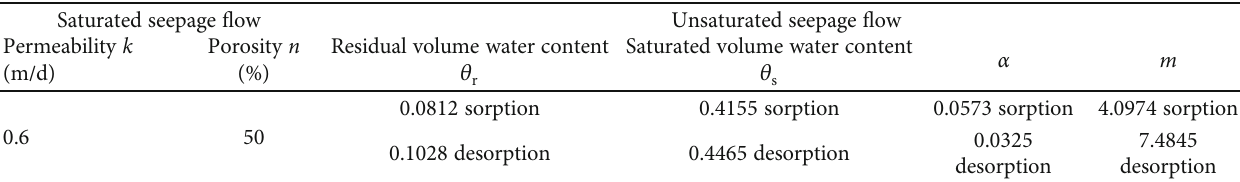
Table 1: Analysis and calculation parameters of slope stability under seepage fl ow condition.